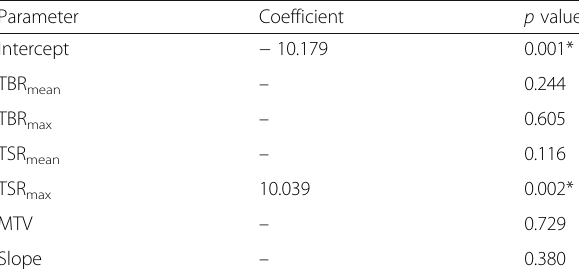
Table 4 Results of logistic regression for the prediction of recurrence/progression at 6 months after [ 18 F]-F-DOPA PET